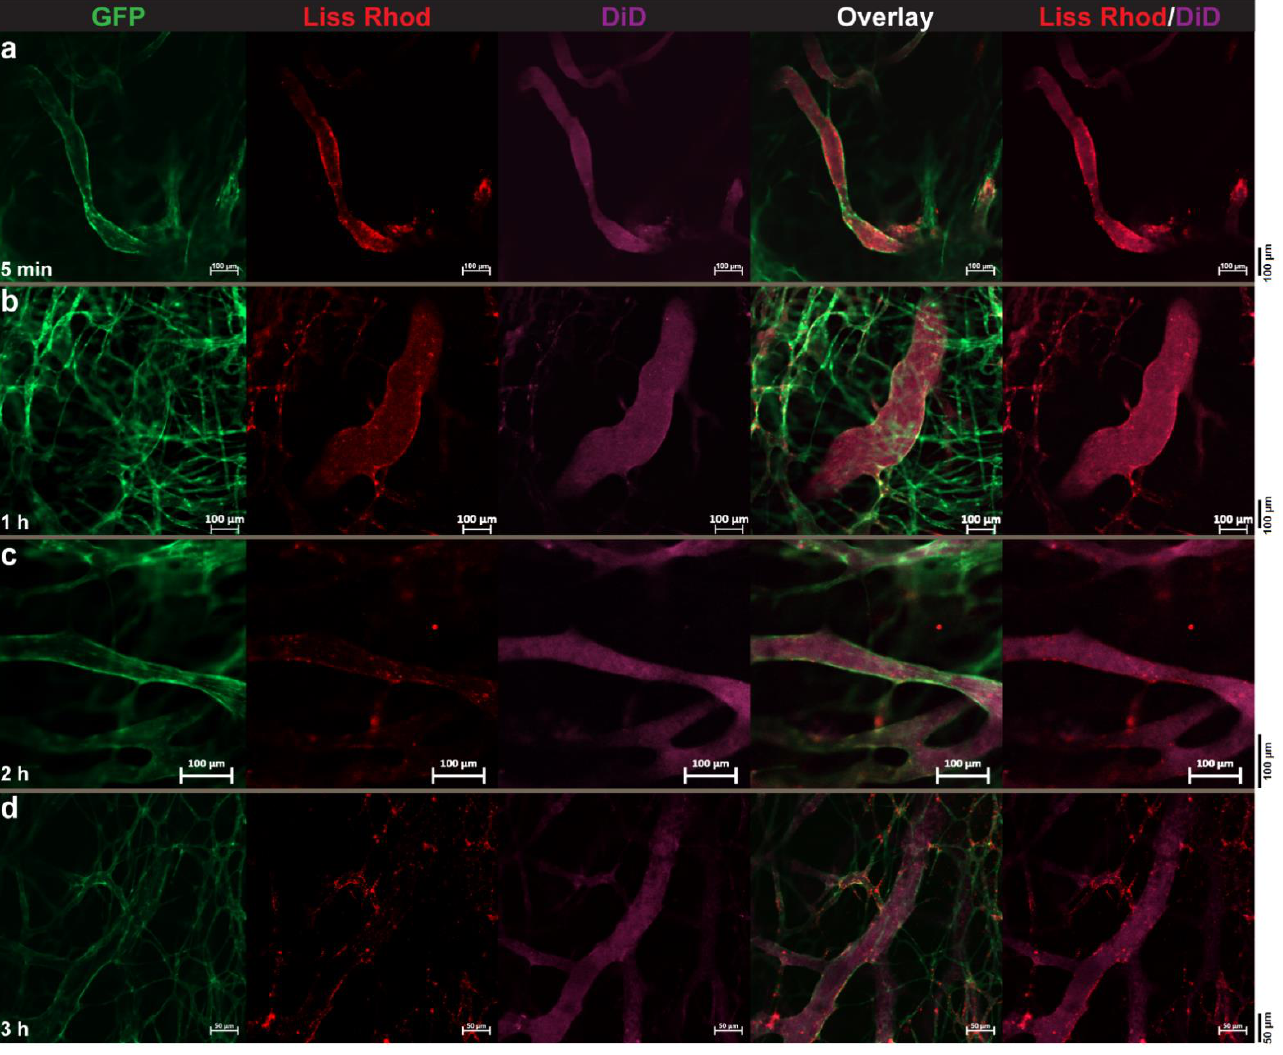
Figure 6. Intravital microscopy of intratumor behavior of Rho-PE-labeled (red) dually targeted-liposomes (D32-FPL) mixed and injected with DiD-labeled TAT-liposomes (T2-FPL). Images were captured at different time points of 5 min to 3 h ( a – d ) after injection show association of D32-FPL (red) with tumor vessels while no significant association between T2-FPL (purple) and tumor vasculature could be seen. Mice were injected with an IV injection of 5 μmol of each liposomal lipids. Green fluorescence of endothelial cells due to eNOStag-GFP expression.